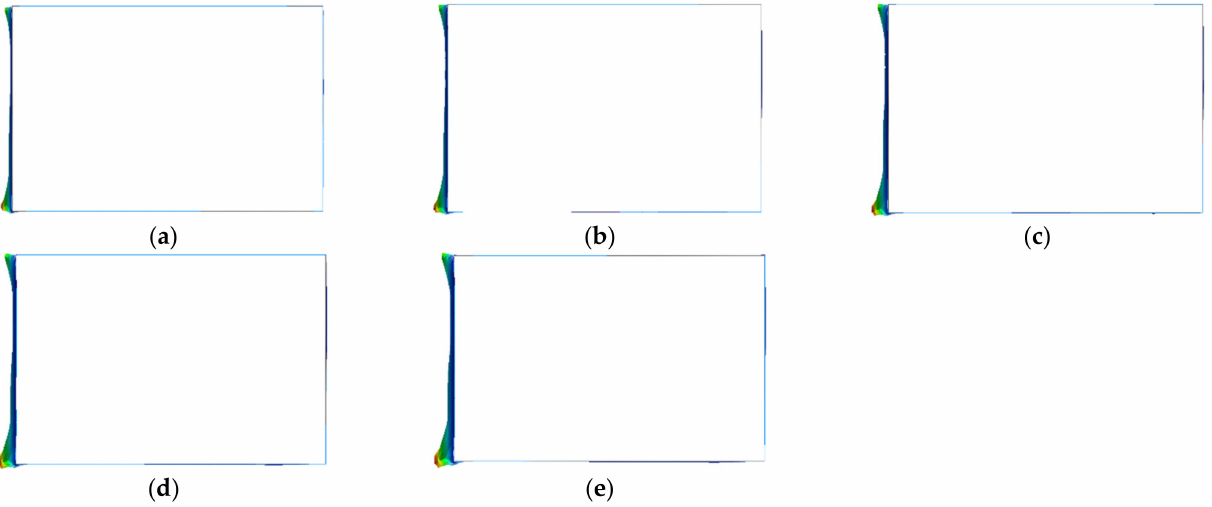
Figure 8. The side view of ice distribution of beams at different temperature. ( a ) The temperature is − 6 ◦ C. ( b ) The temperature is − 8 ◦ C. ( c ) The temperature is − 10 ◦ C. ( d ) The temperature is − 12 ◦ C. ( e ) The temperature is − 14 ◦